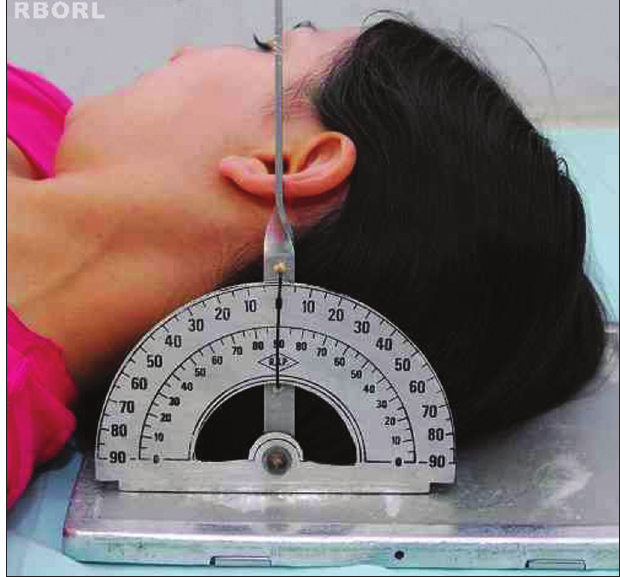
Figura 4. Resultado radiológico esperado (AP Transorbitária).